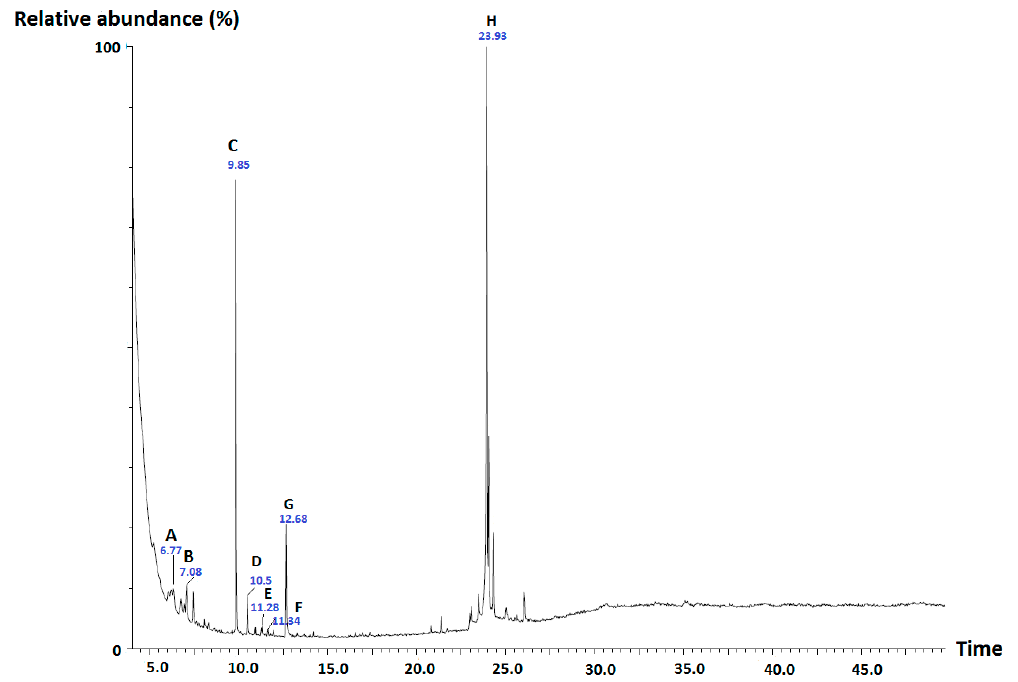
Figure 3. Total ion chromatogram of the n -hexane extract of G. cambogia and tentatively identified compounds. A : β -caryophyllene, B : α -caryophyllene, C : squalene-like compound with m/z 260, D: hexadecane, E: hexadecanoic acid, F : 5a-methoxy-9a-methyl-3,4,5a,6,7,8,9a,10-octahydropyrano[4,3-b]chromene-1,9-dione, G : 1-octadecanol, H : garcinol.